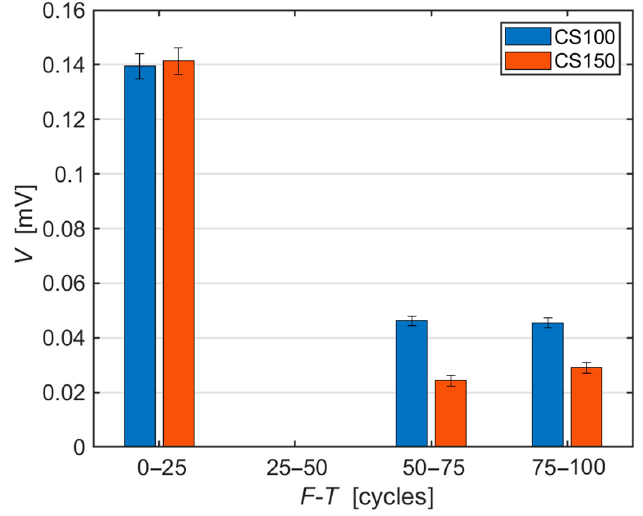
Figure 3. Average amplitude height of AE hits during F-T cycles, error bars represent sample standard deviations.